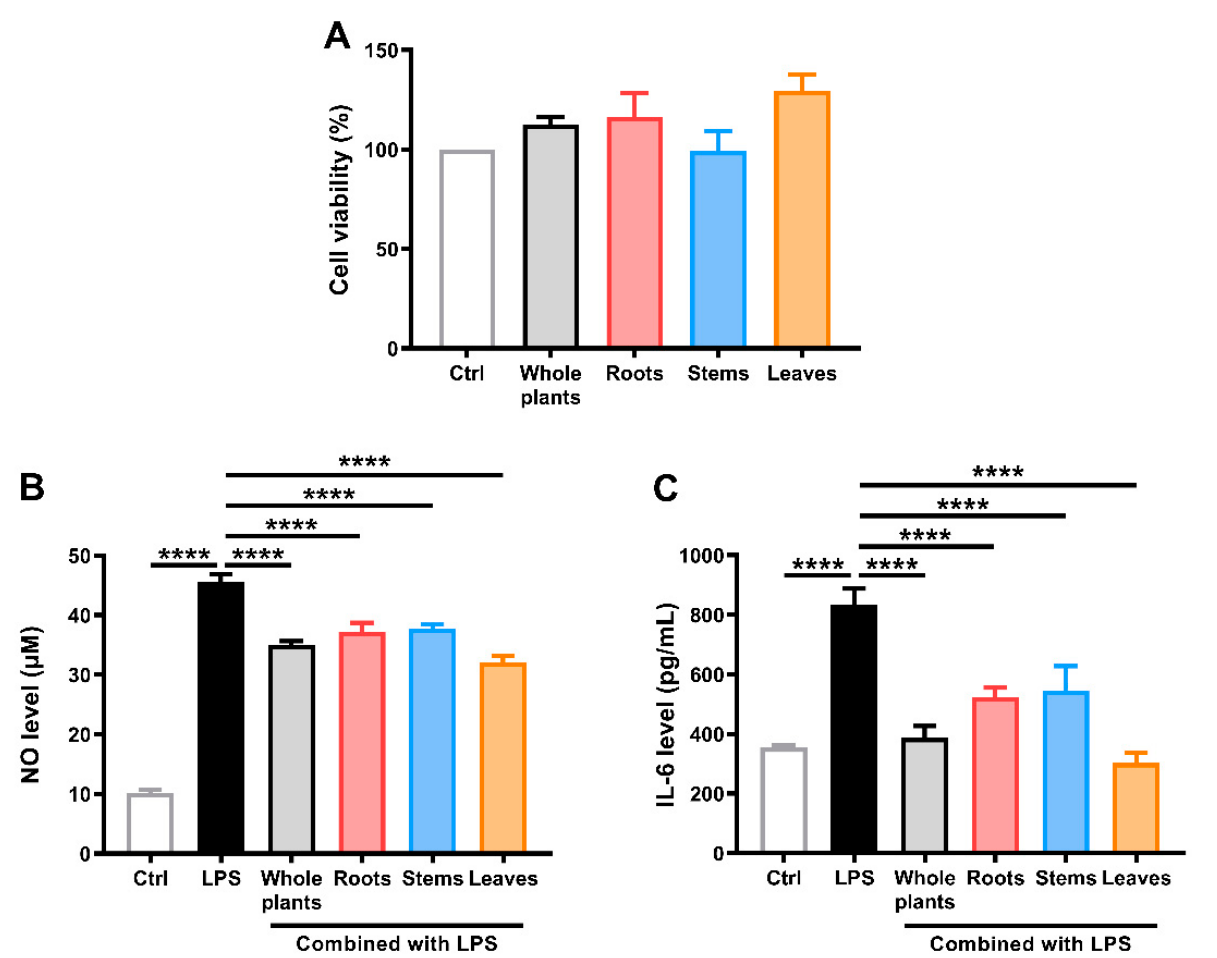
Figure 3. Assessment of the anti-inflammatory activities of the whole plants, roots, stems, and leaves from S. ternatum . ( A ) RAW 264.7 cell viability detected through the CCK-8 assay. ( B ) NO level measurement. ( C ) IL-6 level measurement. The data are shown as means ± SD ( n = 3). **** p < 0.0001 vs. the LPS-stimulated group.